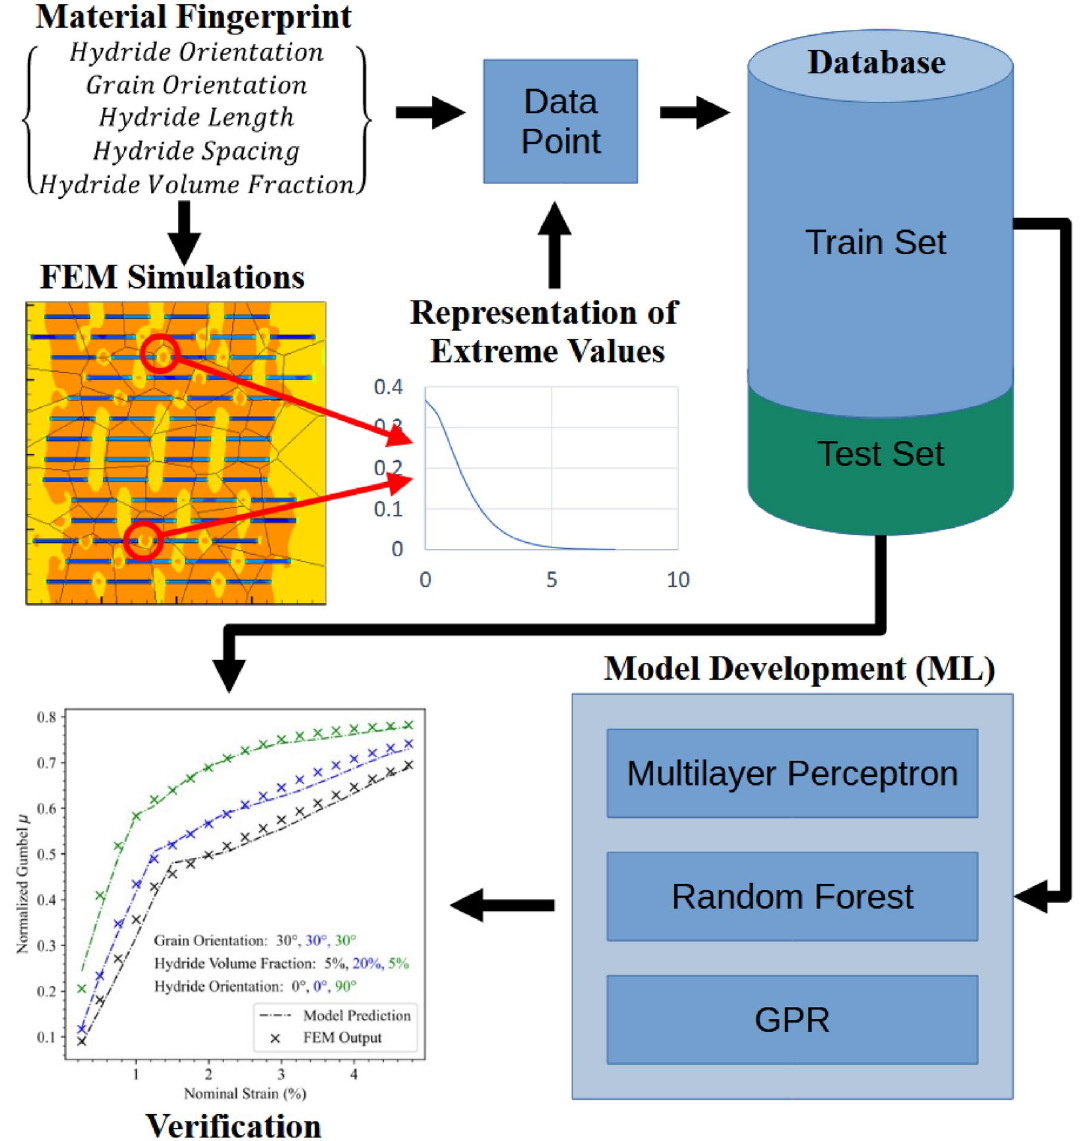
Figure 1. An outline of the proposed ML modeling process . The FEM results are distilled into a representation of their extrema, and then various ML approaches were tested to determine which was best suited to model the data. These models have the material fingerprint as inputs, and then output the material state for a given level of